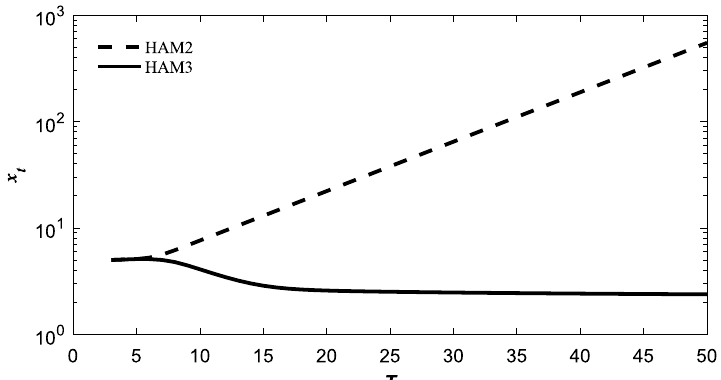
Fig. 7 Responses to a positive shock, corresponding to overvalued assets compared to fundamentals. We assumed that at T = 1 , the deviation value is x = 0 and good news at T = 3 drives x to 5, and the threshold value is x s = 3